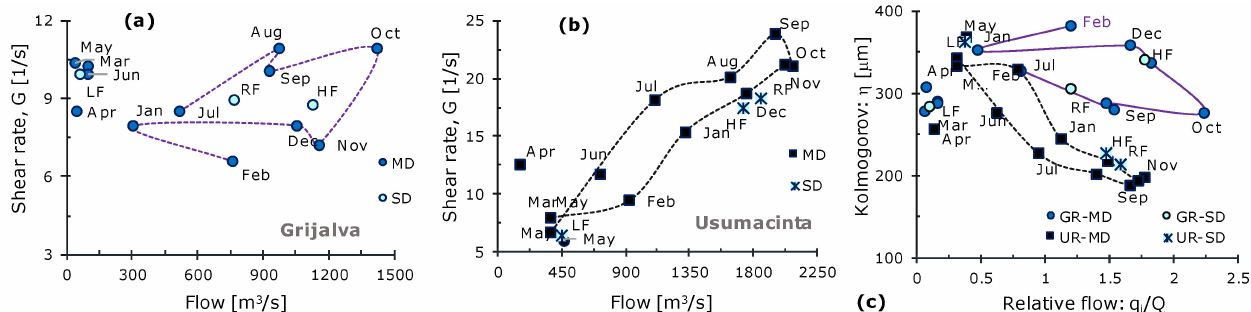
Figure 8. Annual hysteresis patterns in hydrodynamic forces: ( a , b ) Mean shear rate; and ( c ) Mean Kolmogorov microscale. MD: Monthly data (from May 2016 to June 2017); SD: Seasonal data; HF: High flow (November 2021); LF: Low-flow (April 2022); RF: Raising-flow (August 2022). In panel ( c ), GR: Grijalva River; UR: Usumacinta River. Purple lines show hysteresis